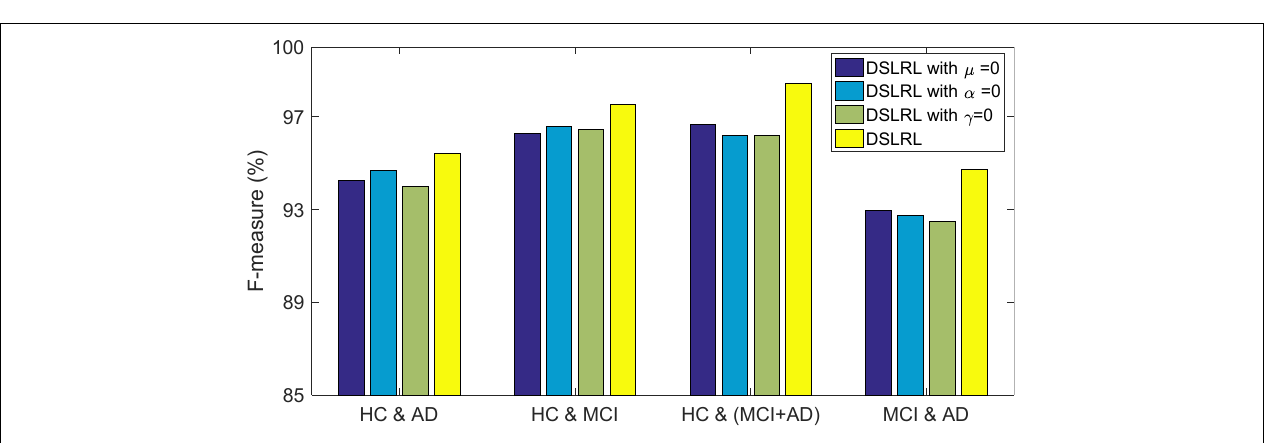
FIGURE 3 | F-measure of DSLRR with ablation experiment in four EEG